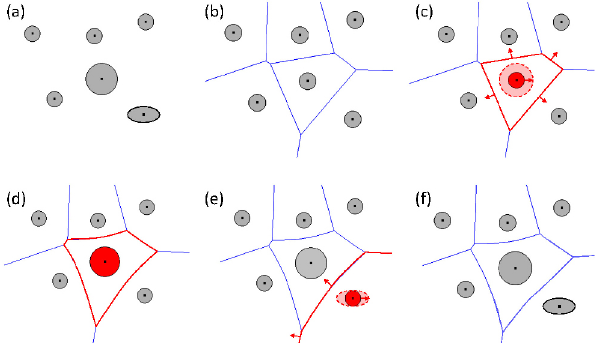
Fig. 8 Cell-expansion process: (a) input, (b) ordinary Voronoi diagram, (c, d) expanding the Voronoi cell of one special site, (e) expanding the Voronoi cell of the second special site, (f) result. The expanding input sites and Voronoi cells are in red.